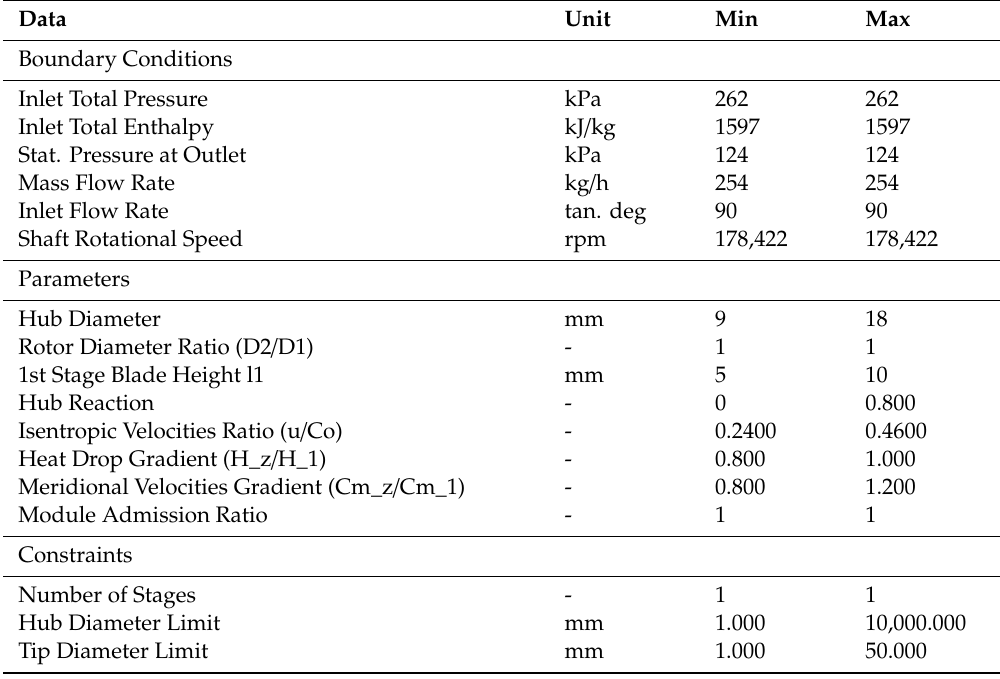
Table 1. Table of predesigned boundary conditions (AxSTREAM Inverse Task